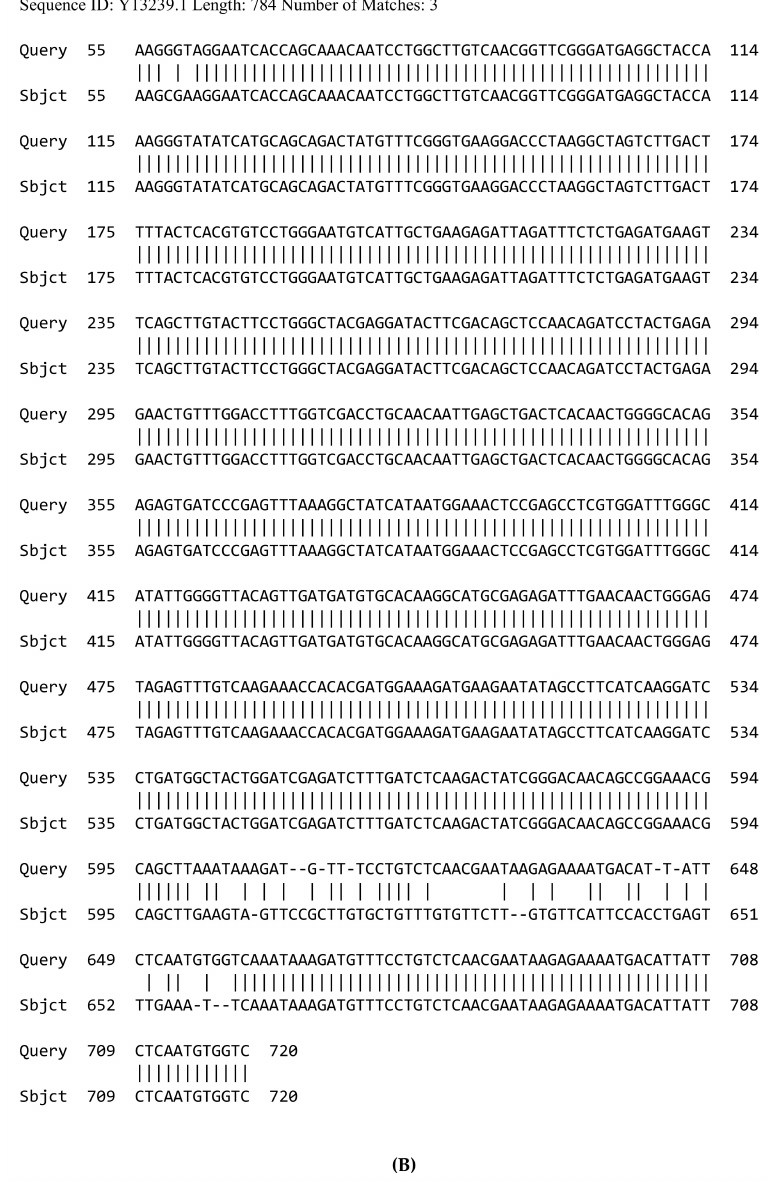
Figure 7. Sequence analysis of jojoba glyoxalase I gene. ( A ) Comparison of the predicted amino acid sequences of glyoxalase I from jojoba ( Jojo-Gly I ), with glyoxalase I gene conferring tolerance to plants under stress, glyoxalase I gene from Brassica juncea (Accession number: emb CAA73691.1). The deduced amino acid sequence of the glyoxalase I gene product is shown and the amino acids that di ff er from the glyoxalase I gene product are indicated. ( B ) Multiple sequence alignment of jojoba glyoxalase I ( Jojo-Gly I ) was carried out using Blast. Comparison of the nucleotide sequences of Jojo-Gly I from jojoba with glyoxalase I sequence of Arabidopsis thaliana lactoylglutathione lyase family protein / glyoxalase I family protein (AT1G08110), Mrna. Sequence ID: NM_001035918.2 Length: 1021 Number of Matches: 2, calculates the statistical